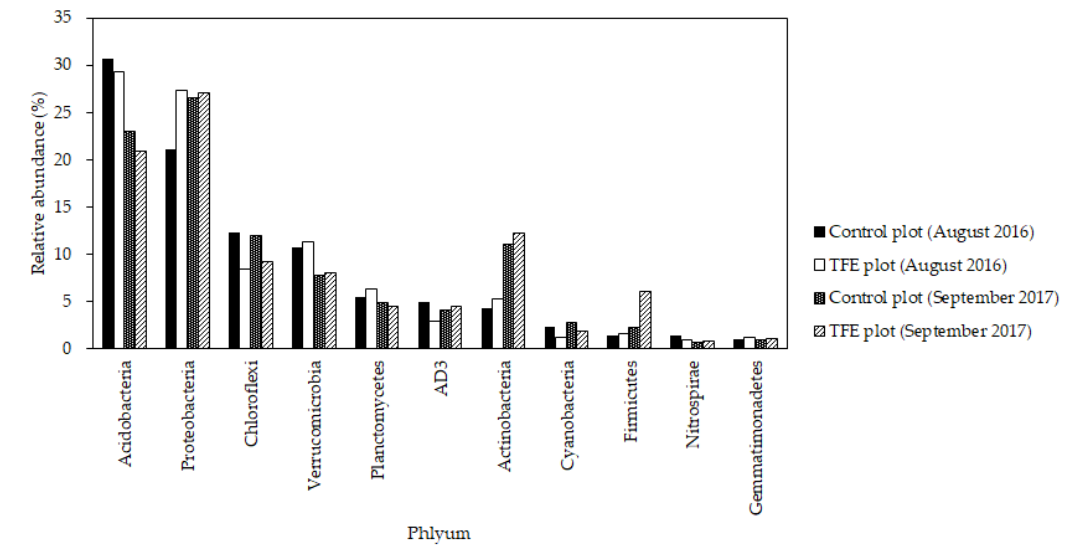
Figure 8. Relative abundance of dominant bacterial phyla in the soil bacterial communities.